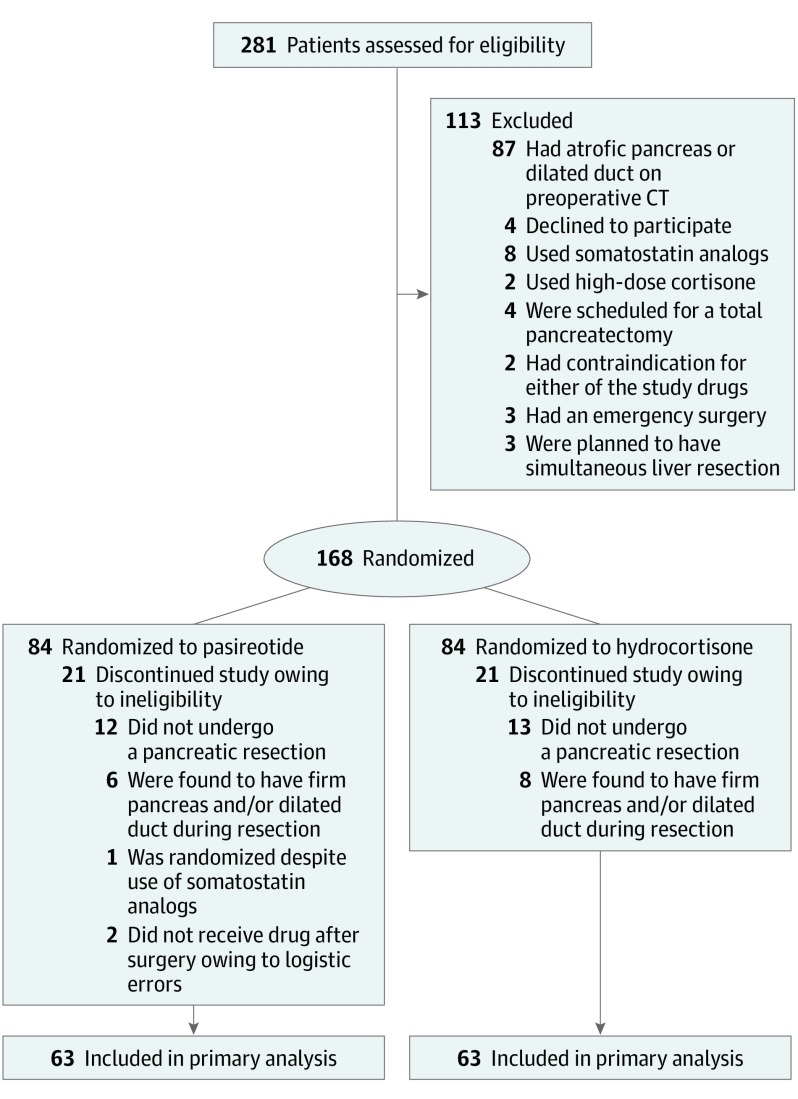
Flow Diagram of Patient Recruitment and RandomizationCT indicates computed tomography.